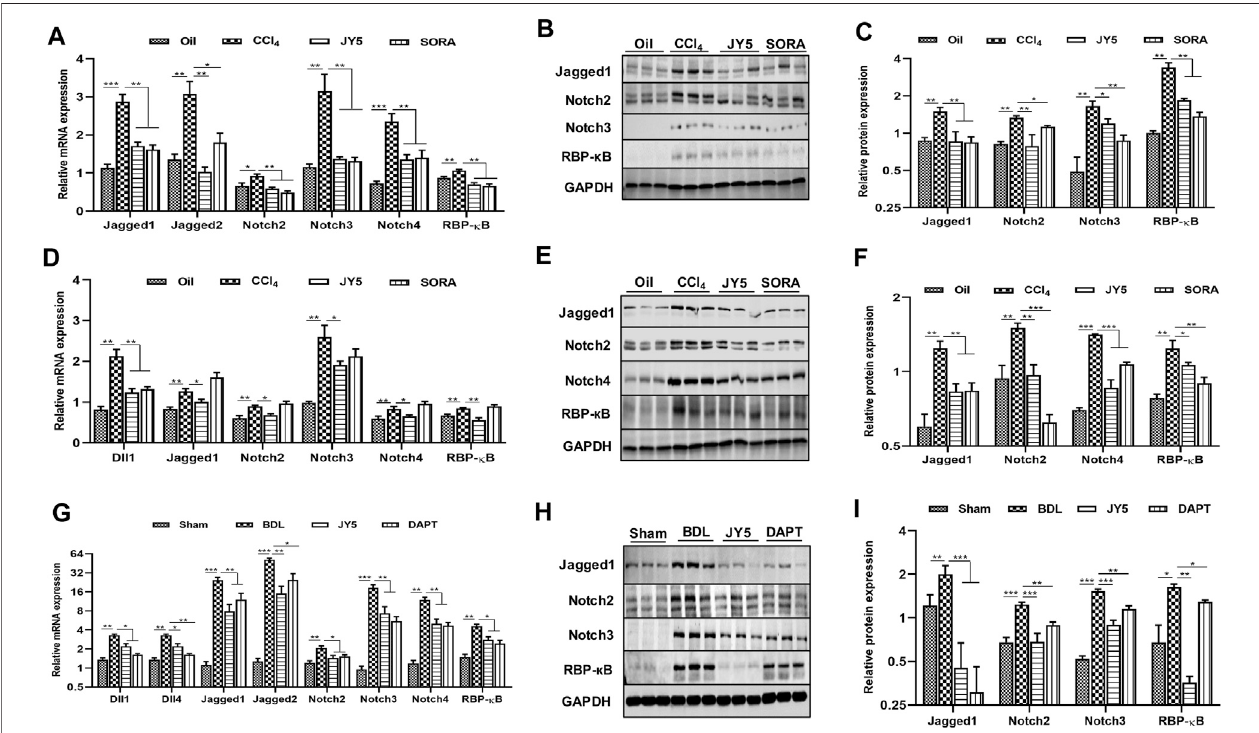
FIGURE6| JY5mayameliorateliver fi brosisbyinhibitingtheNotchsignalingpathway invivo . (A) IntheCCl 4 -inducedratliver fi brosisexperiment,themRNAlevels of Jagged1, Jagged2, Notch2, Notch3, Notch4 and RBP- κ B were measured by qPCR. Western blotting (B) and quantitative analysis (C) of Jagged1, Notch2, Notch3 and RBP- κ Bprotein. (D) IntheCCl 4 -induced liver fi brosis mice experiment, themRNA levelsof Dll1,Jagged1, Notch2,Notch3,Notch4 and RBP- κ B weremeasured by qPCR. Western blotting (E) and quantitativeanalysis (F) ofJagged1, Notch2,Notch4 and RBP- κ Bprotein. (G) Inthe BDL-induced rat liver fi brosis experiment, the mRNA levels of Dll1, Dll4, Jagged1, Jagged2, Notch2, Notch3, Notch4 and RBP- κ B were measured by qPCR. Western blotting (H) and quantitative analysis (I) of Jagged1, Notch2, Notch3 and RBP- κ B protein. * p < 0.05, ** p < 0.01, *** p < 0.001 vs the control group or sham group, # p < 0.05, ## p < 0.01, ### p < 0.001 vs the CCl 4 group or BDL group. Oil: control